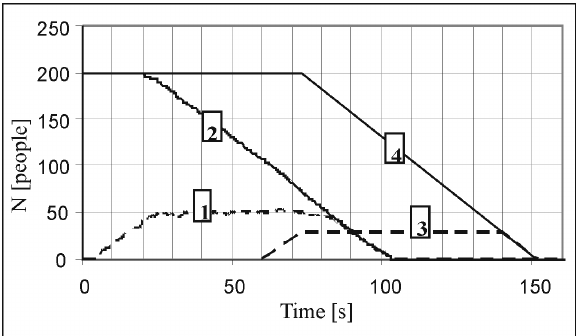
Fig. 3. Number of people versus evacuation time in build- ing and lobby: 1 – lobby (FDS+Evac); 2 – building (FDS+Evac); 3 – lobby (simplified method); 4 –